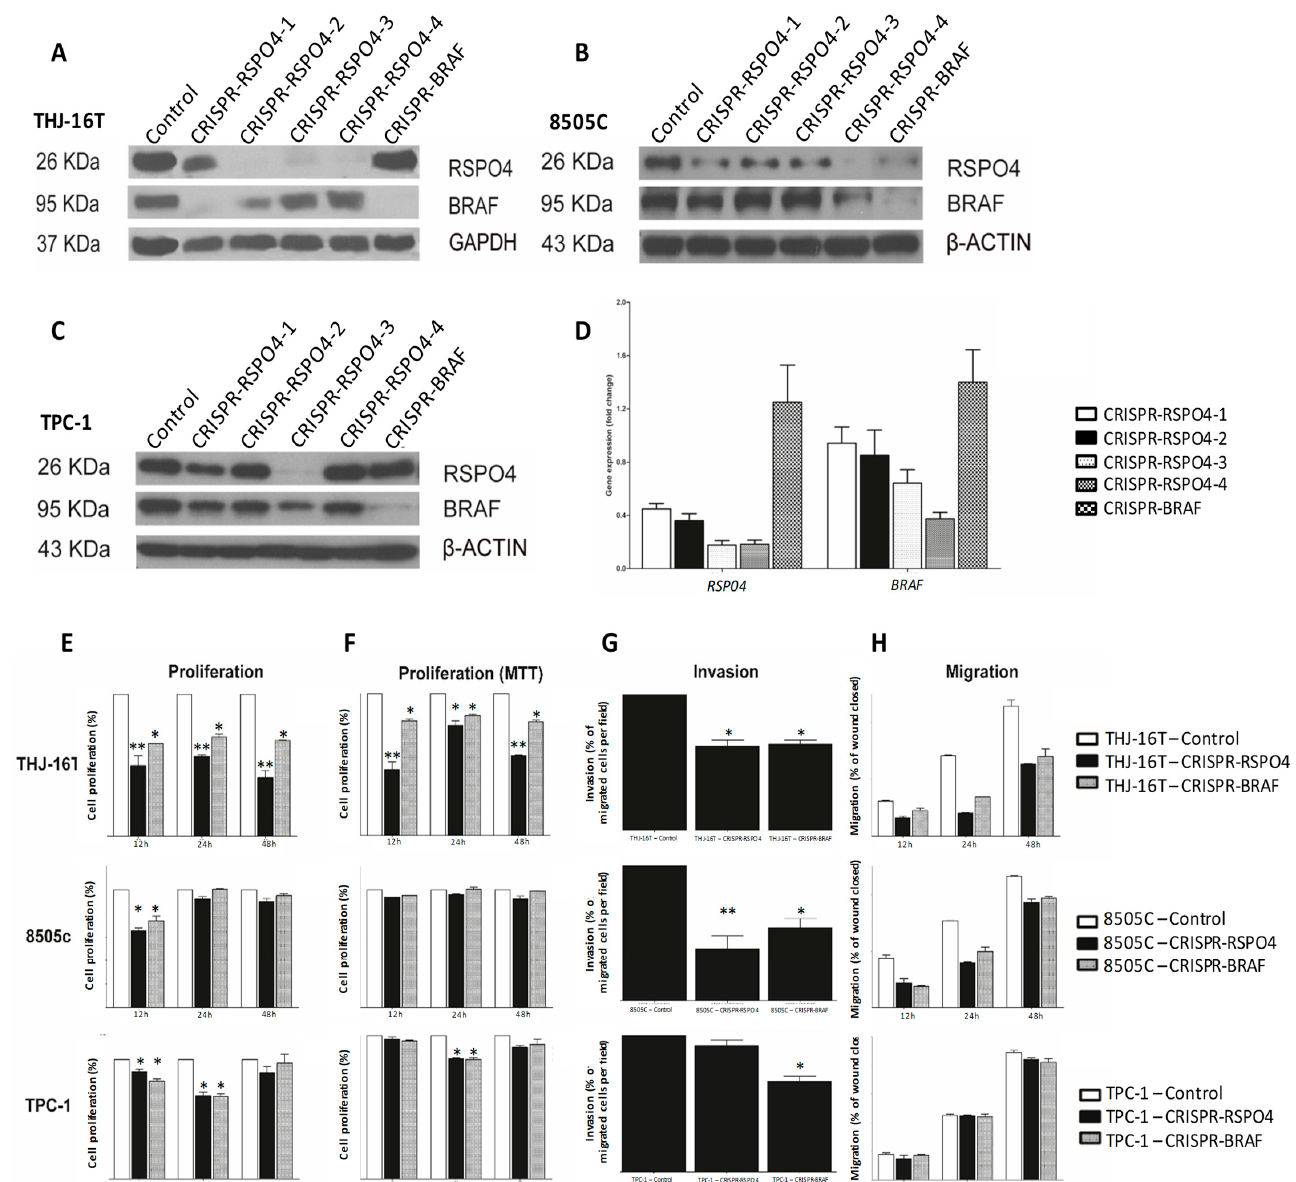
Figure 6. Identification of RSPO4 and BRAF sequence to gene knockout by CRISPR in metastatic and non-metastatic papillary thyroid cancer cell lines. THJ-16T ( A ), 8505c ( B ), and TPC-1 ( C ) cells were knockout using four different sequences for RSPO4 and one BRAF, which the protein and gene expression were verified by Western Blot ( A – C ) and qRT-PCR, respectively ( D ). ( A ) Western Blot of THJ-16T. ( B ) Western Blot of 8505c. ( C ) Western Blot of TPC-1. ( D ) RT-qPCR of THJ-16T relative to the control. The RSPO4 sequence 3 showed high efficiency to knockdown the gene all cell lines of the study. RSPO4 and BRAF knockdown decrease the proliferation, invasion, and migration in human thyroid cancer cell lines ( E – H ). After the knockout, CRISPR-RSPO4 metastatic cells (THJ-16T and 8505c) showed decrease in proliferation (measuring by cellular count and MTT assay), invasion, and migration. Error Bars represent SD from two three independent experiments.* p = 0.05, ** p < 0.01.